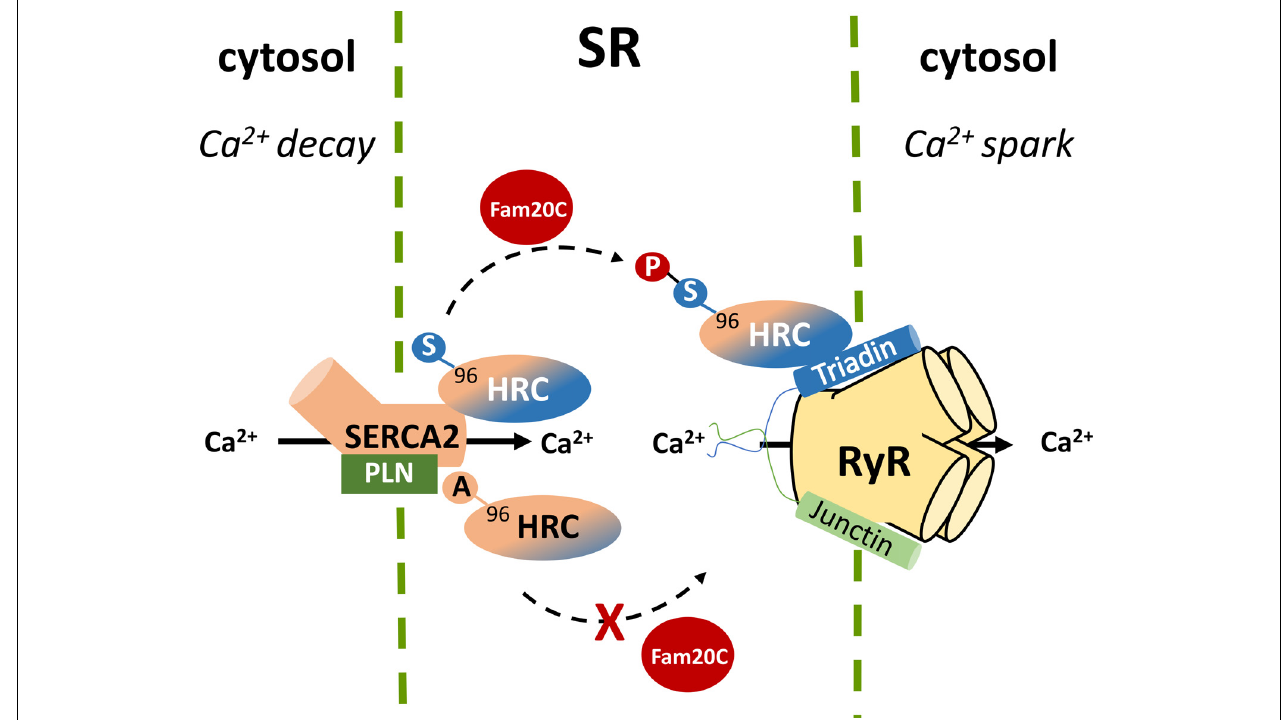
FIGURE 3 | Histidine-rich calcium binding protein phosphorylation by Fam20C at Ser96 affects the affinity of HRC interactions with SERCA2 and triadin while the Ala96 variant remains unaffected.